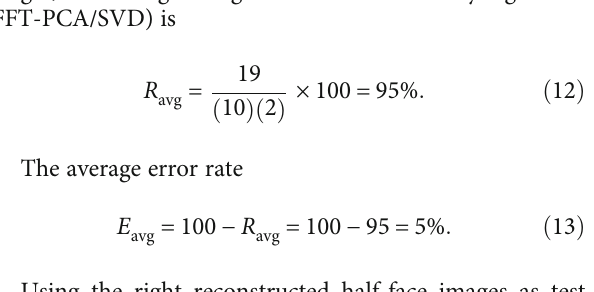
Figure 8: Normal Q ‐ Q plot of observed di ff